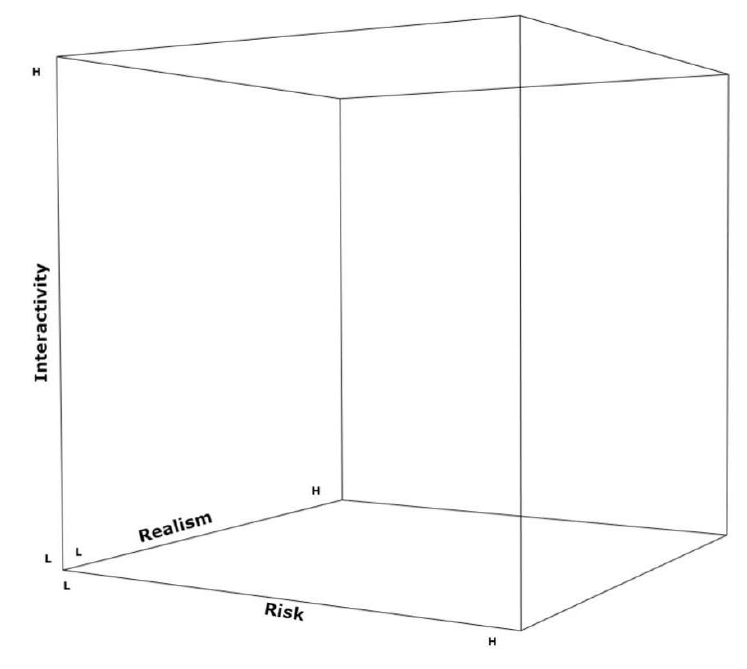
Figure 2. Climate Visualizations for Adaptation Products (CVAP).